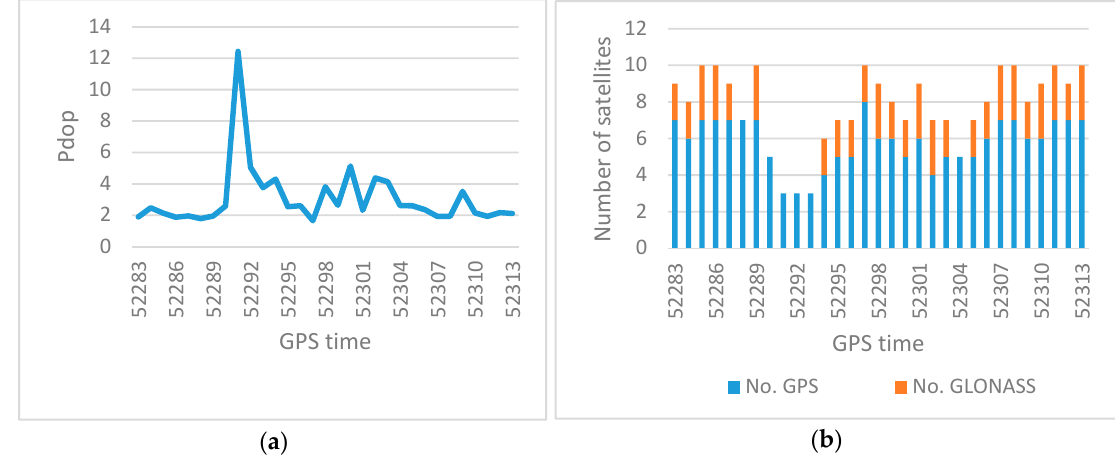
Figure 2. The position dilution of precision (Pdop) during data capture is shown in ( a ) and ( b ) shows the number of satellites in the same time period.